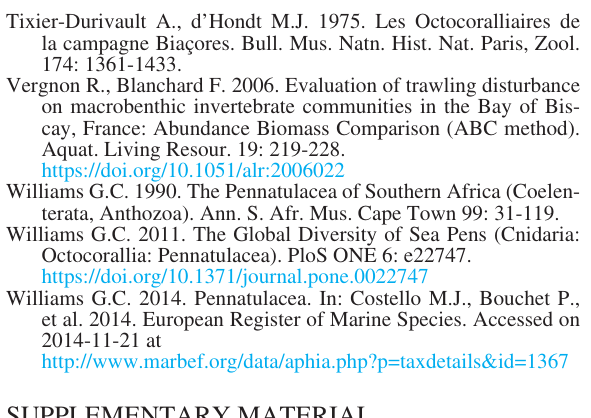
Table S1. – Pennatulacea occurring in the southern sector of the Bay of Biscay (off Spain) south of the 44°N parallel and Galicia after a review of the literature contrasting with our results in the study area from 1995-2010 (* data collected from 2008- 2014). Only references with the shallow-most and deep-most data included. Table S2. – Species composition of the aggregations of F. quadran- gularis on circalittoral and upper bathyal soft bottoms and of Pennatula spp. on circalittoral soft bottoms. Taxon: A, ascidian; C, cnidarian; CR, crustacean; E, echinoderm; M, mollusc, P, polychaete worm; S, sponge. Species: * species that occur in the aggregations of F. quadrangularis on circalittoral soft bot- toms but not in the upper bathyal soft bottoms; ** species that occur in the aggregations of F. quadrangularis on bathyal soft bottoms but not on circalittoral soft bottoms; *** species that occur in the aggregations of Pennatula spp. on circalittoral soft bottoms but not in the aggregations of F. quadrangularis on circalittoral soft bottoms. %: percentage of frequency of occur-